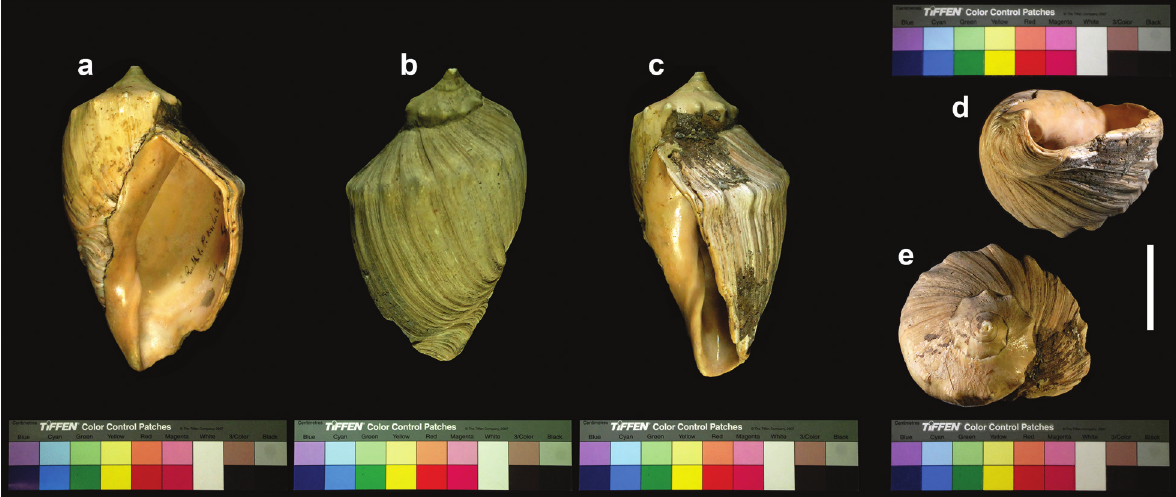
Figure 36. Voluta colocynthis spirabilis , specimen figured by Lahille (1895: pl. I, fig. 4; pl. V, fig. 37) a Apertural view b Dorsal view c Lateral view d Umbilical view e Apical view. Scale bar: 5 cm.